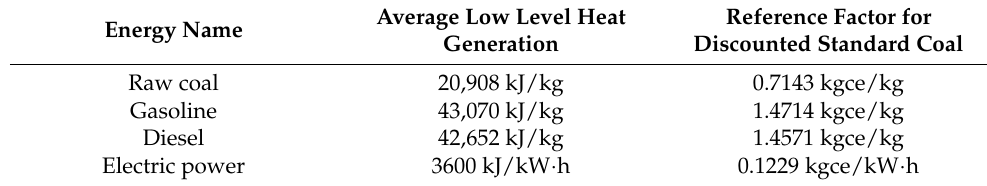
Table 3. Reference factor for discounted standard